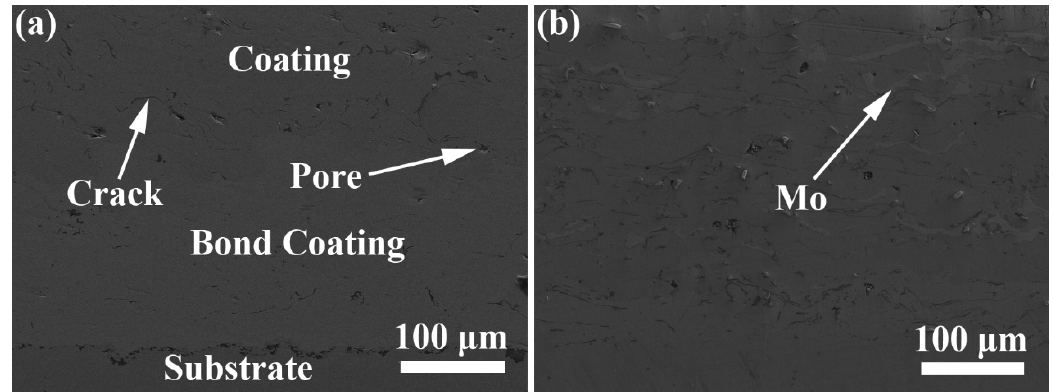
Figure 2. SEM morphologies of cross-sections of the coatings: ( a ) NiCrAlY and ( b ) NiCrAlY–Mo.